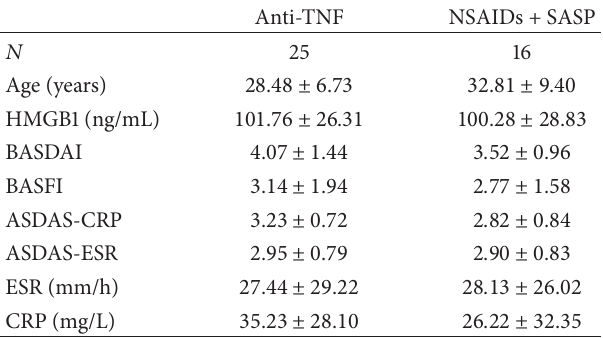
Table 3: Baseline characteristics of the two follow-up therapeutic AS groups.